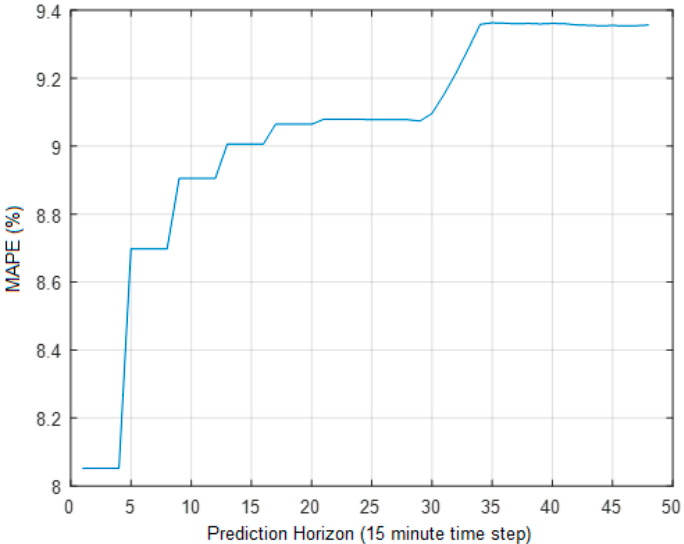
Figure 15. MAPE (in %) of the PV power within the prediction horizon. In [31], the MAPE criterion is also employed. For a 5 min forecast, MAPE ranges between 2.2% and 11.2%. In our approach, the MAPE for a 15 min forecast is 8.0%. The work presented in [33] also employs the MAPE criterion. For summer months, for 6, 12, and 24 h the values obtained were 28.6%, 38.5% and 37.8%. In our approach, 9.1% and 9.4% were obtained for 6 and 12 h ahead.